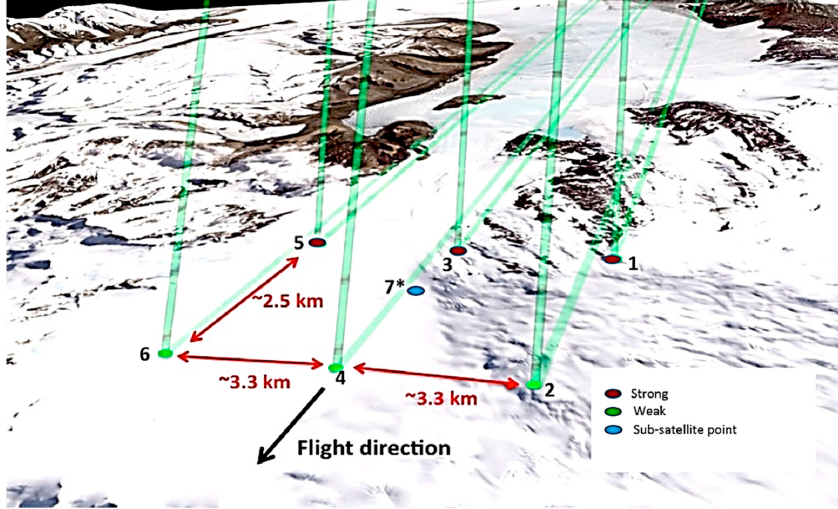
Figure 2. Ice, Cloud, and Land Elevation Satellite-2 (ICESat-2) beam configuration on the Earth’s